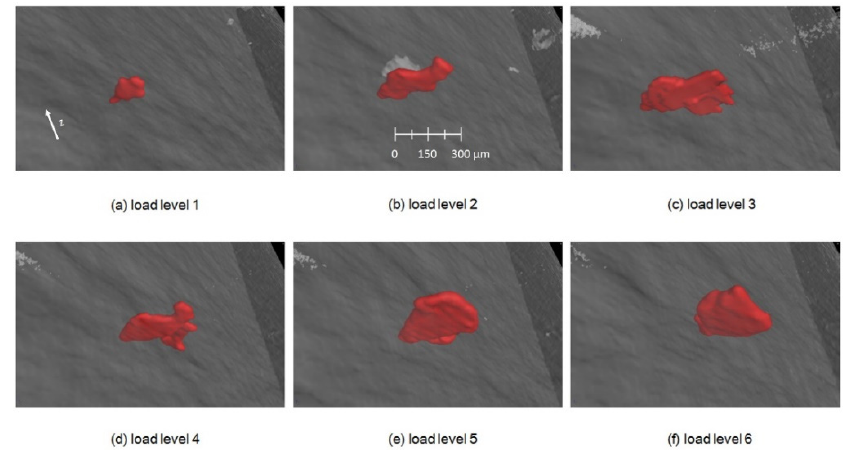
Figure 14. Change of the failure-critical defect, marked in red, of a BASCA heat-treated Ti-5553 alloy using E L = 600 J/m. Load level: ( a ) 2900 N, ( b ) 2975 N, ( c ) 3050 N, ( d ) 3125 N, ( e ) 3155 N and ( f ) 3170 N.